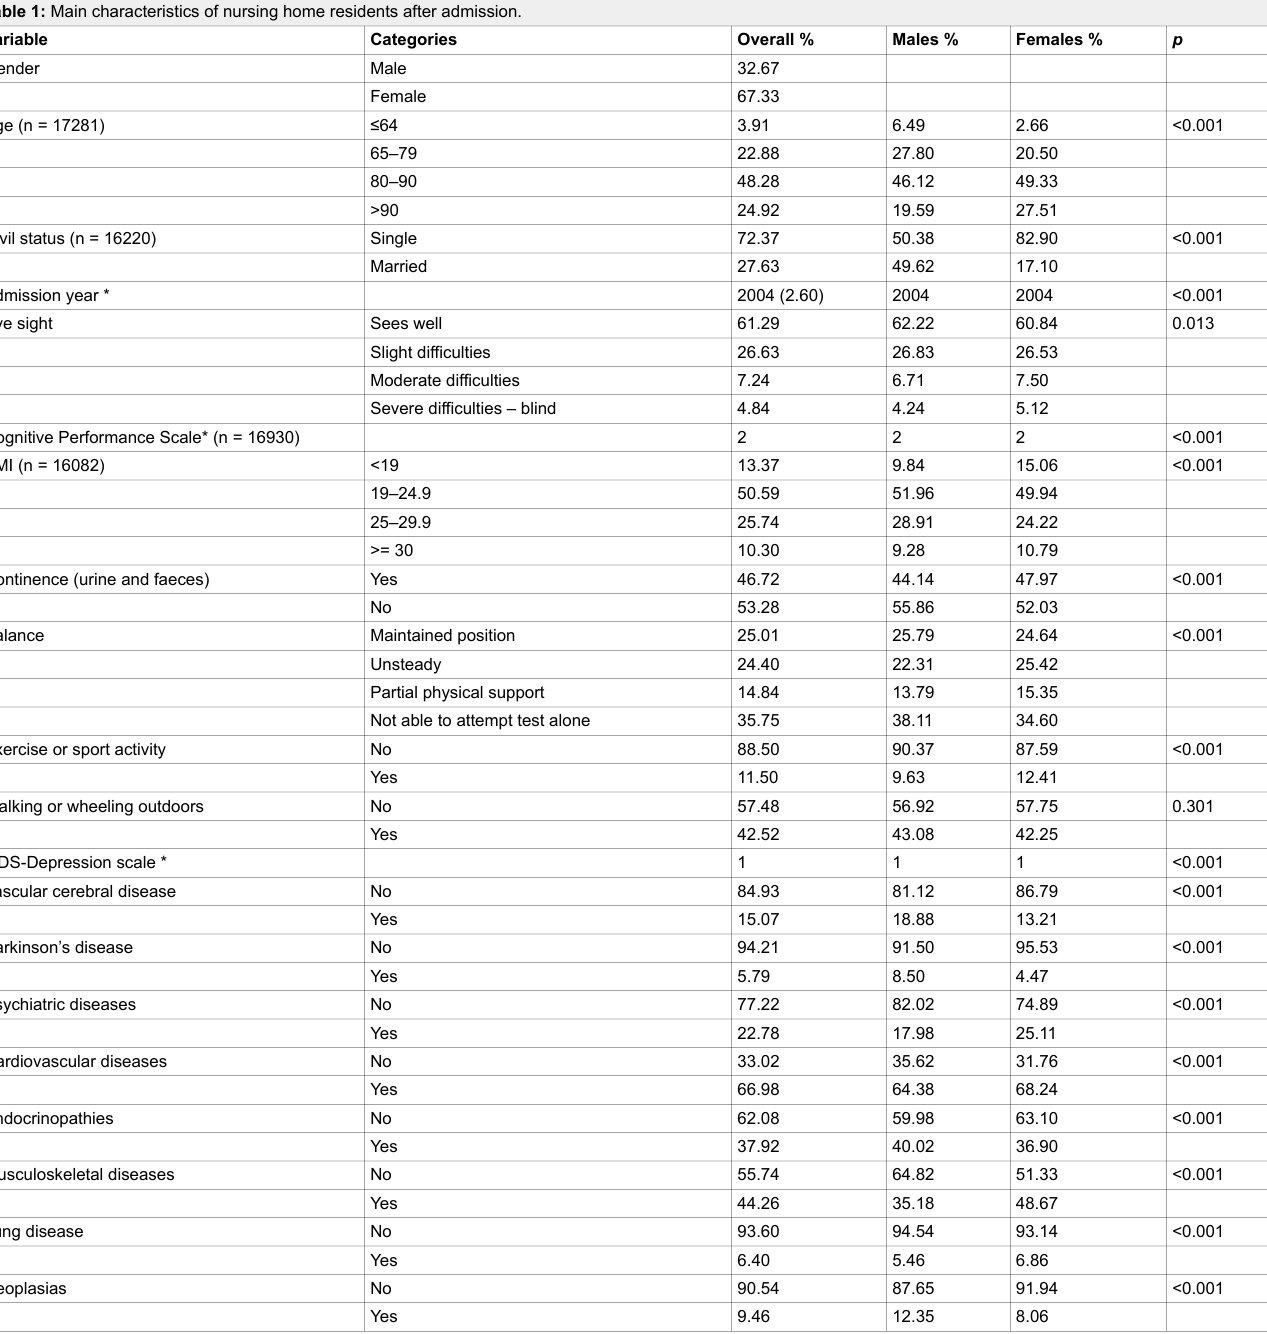
Table 1: Main characteristics of nursing home residents after